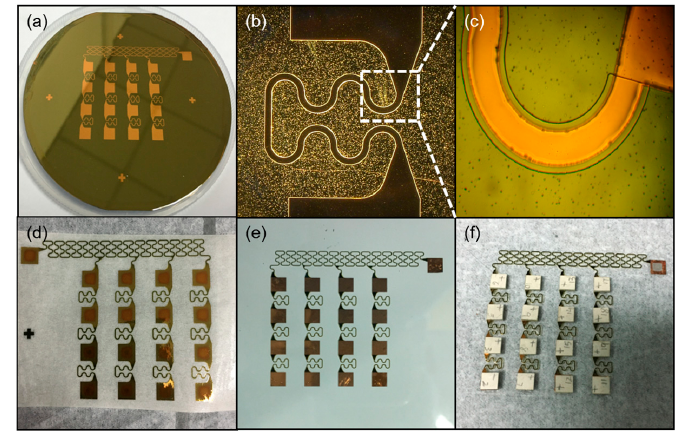
Figure 3. Effects of flexible interconnection in different steps. ( a ) The second layer of polyimide (PI) for the protective layer. ( b ) The Cu layer was patterned as serpentine structures. ( c ) The SiO (cid:2870) hard mask after photolithography. ( d ) The flexible interconnection was retrieved by water-soluble tape. ( e ) The flexible interconnection was transferred on a new PDMS layer. ( f ) The flexible interconnection and the lead zirconate titanate (PZT) array were combined.